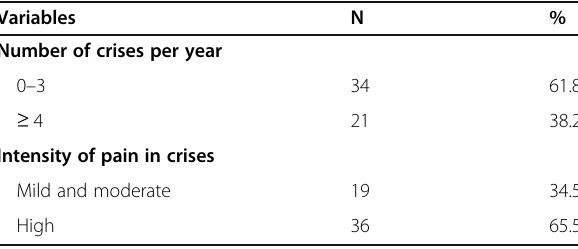
frequency and intensity of painful